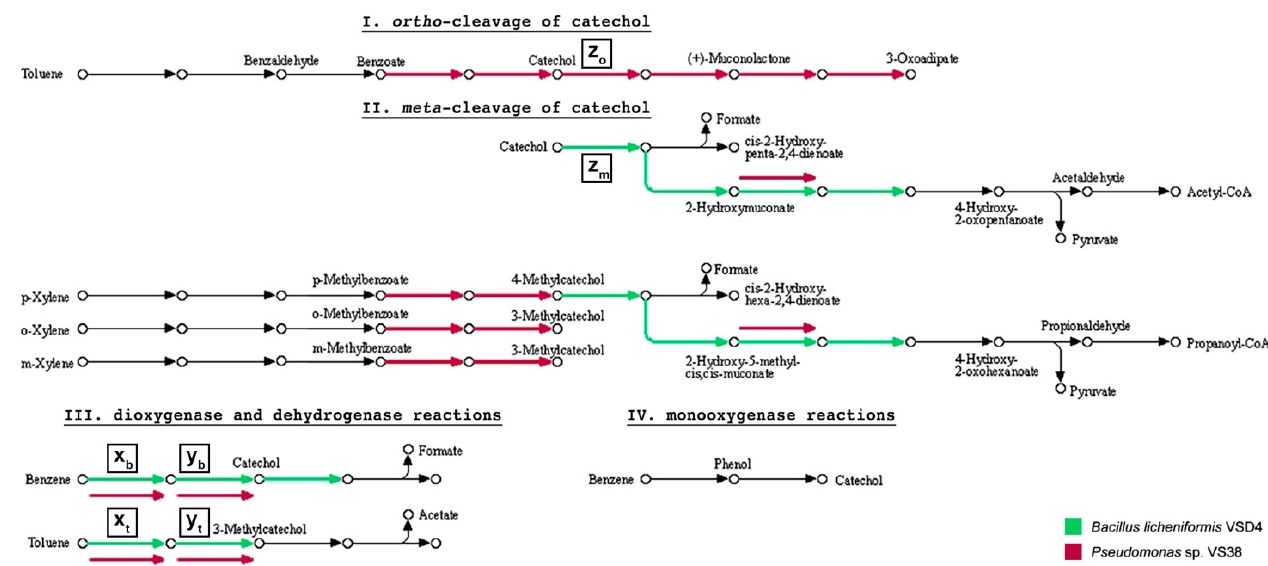
Figure 5. BTX degradation pathways. KEGG orthology (KO) identifiers were assigned to individual genes in the genomes of benzene, toluene, and/or ortho(o) -, meta(m) -, para(p) -xylene (BTX) degraders Bacillus licheniformis VSD4, Pseudomonas sp. VS38, and Rhodotorula sp. VS67, followed by reconstruction of KEGG pathways related to BTX degradation, categorized